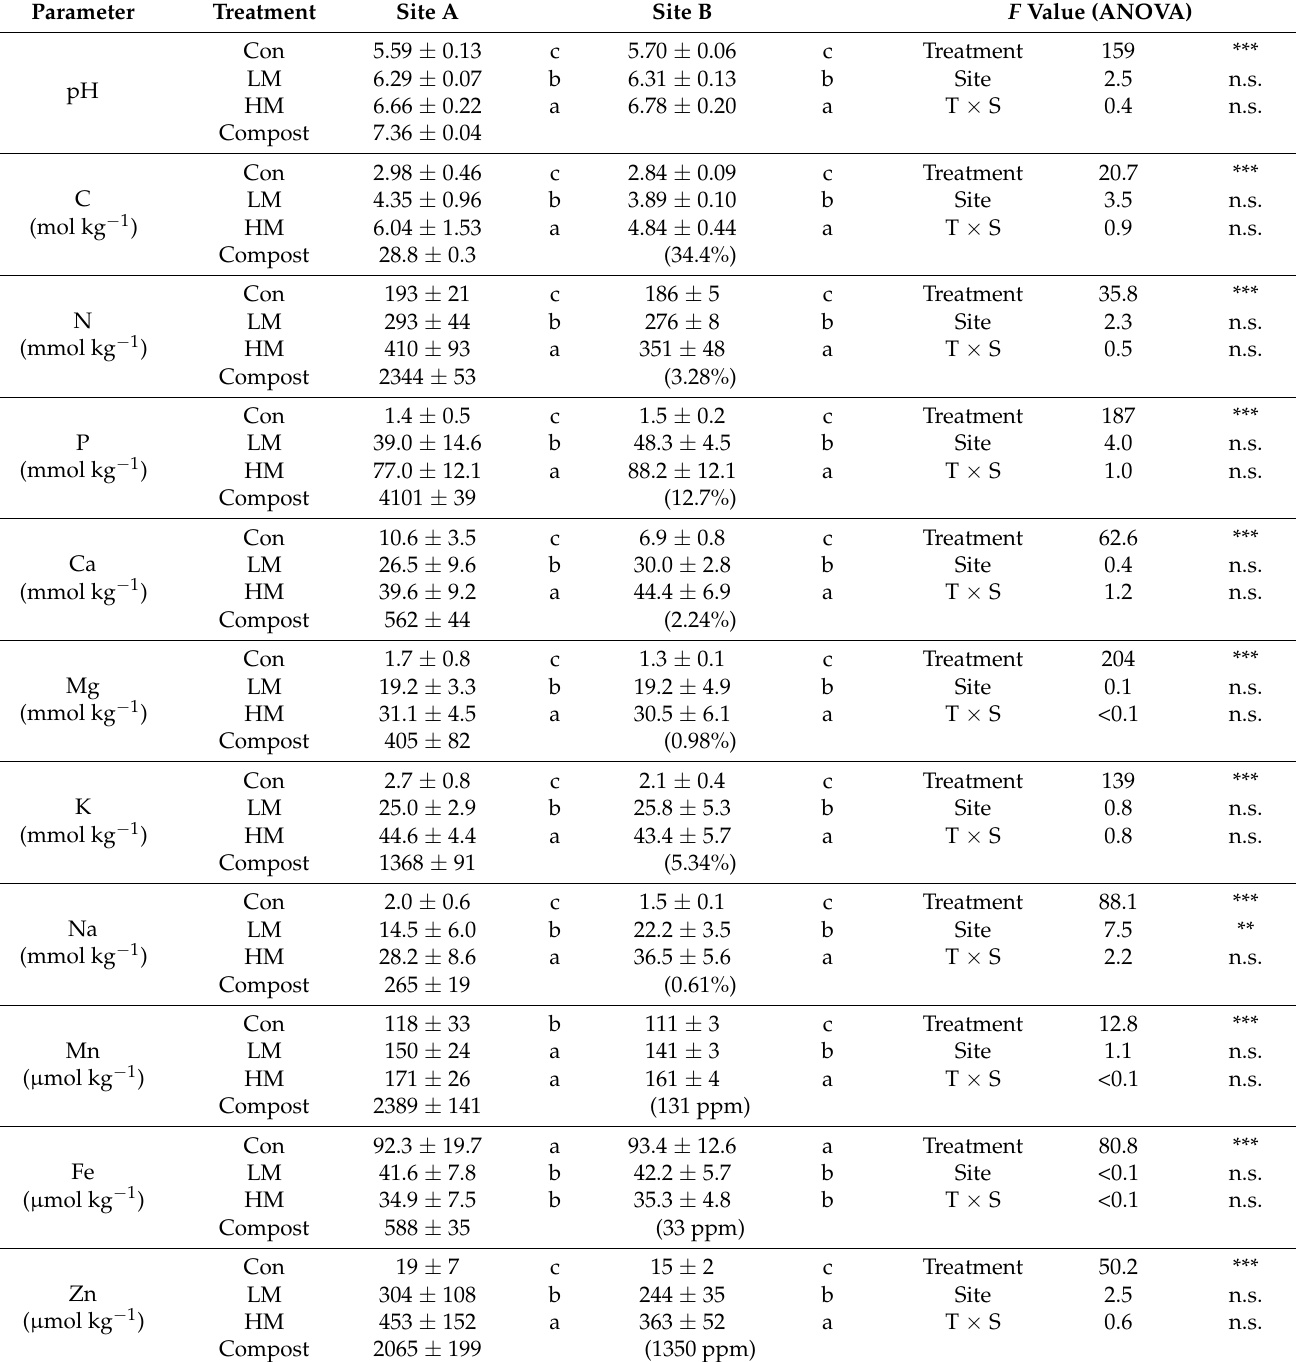
Table 2. Chemical properties of soils after treatments in Site A ( n = 12), Site B ( n = 4), and compost ( n = 4) (mean ± SD). Asterisks indicate significant differences among three treatments, two sites, and their interaction (T × S) calculated by ANOVA. ** = p < 0.01 and *** = p <